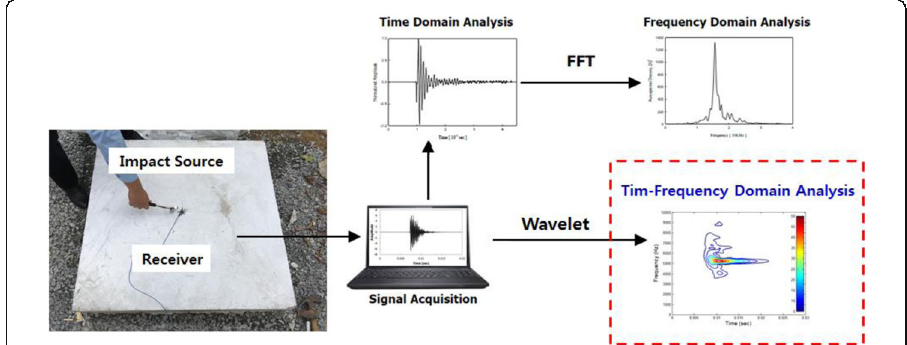
Fig. 3 Time-frequency analysis